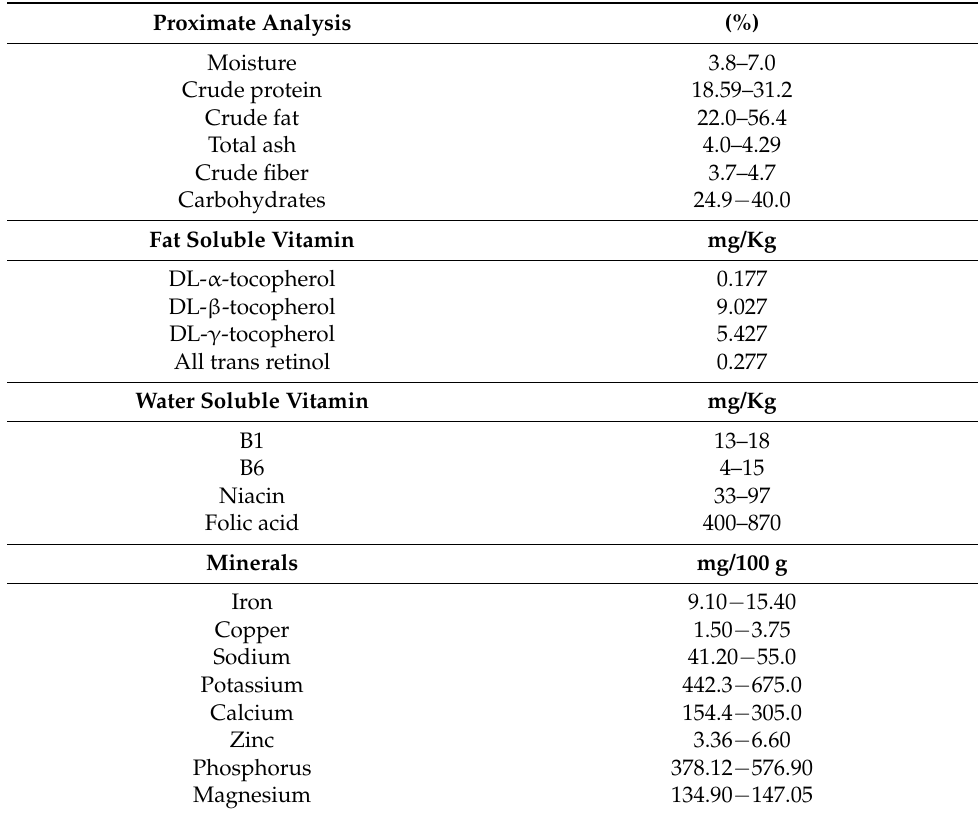
Table 1. Chemical and nutritional composition of Nigella sativa